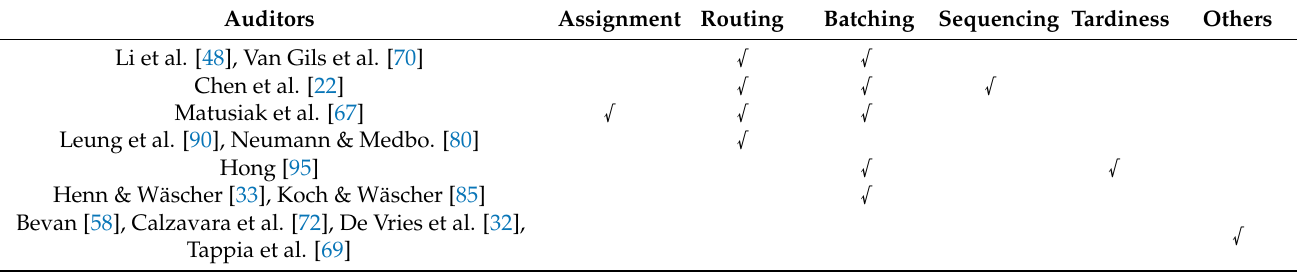
Table 7. Overview of the reviewed articles in maximization of